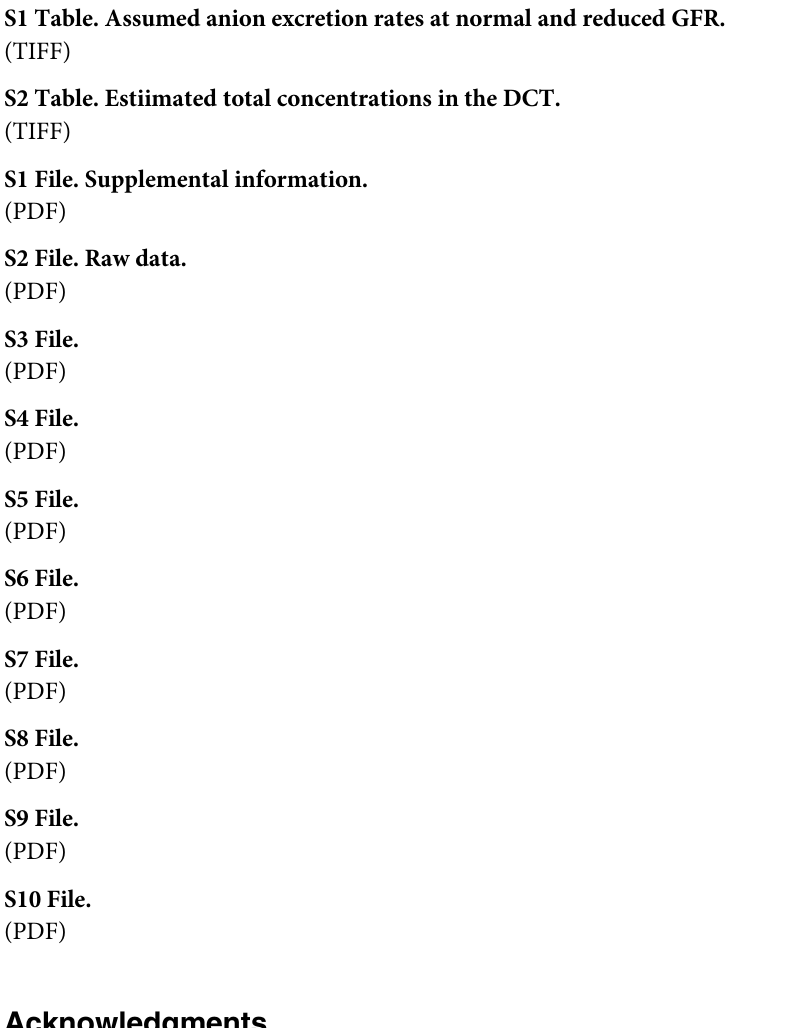
S7 Fig. Regressions at FD of 0.2 and pH of 6.6 (a-c), 6.8 (d-f), and 7.0 (g-i). Ca (TIFF) S1 Table. Assumed anion excretion rates at normal and reduced